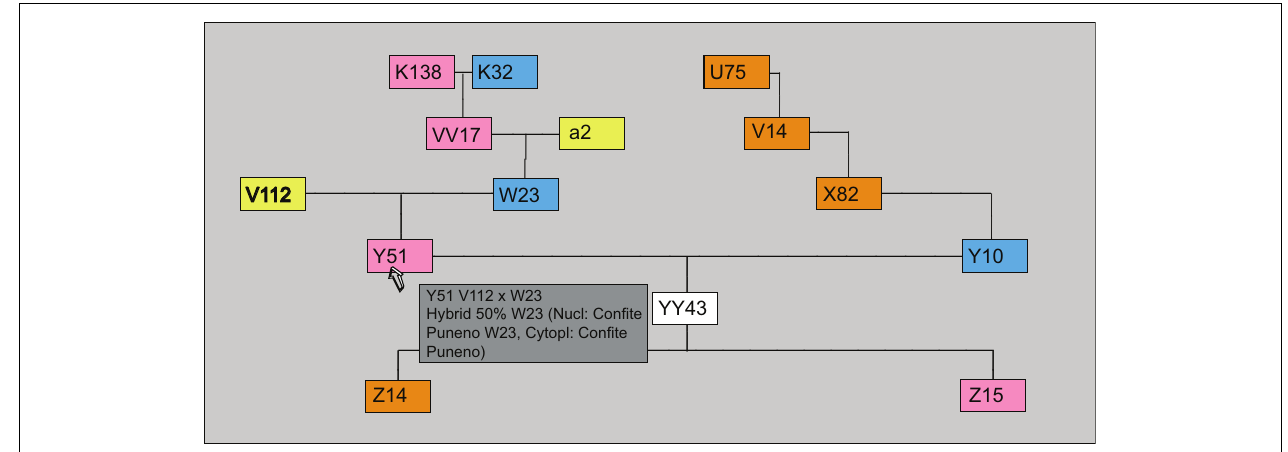
FIGURE 2 | Detail of pop-up box feature of the family tree display. A pop-up box with a gray background is shown for individualY51, the maternal parent of YY43, is shown. Mousing over an individual generates a pop-up.